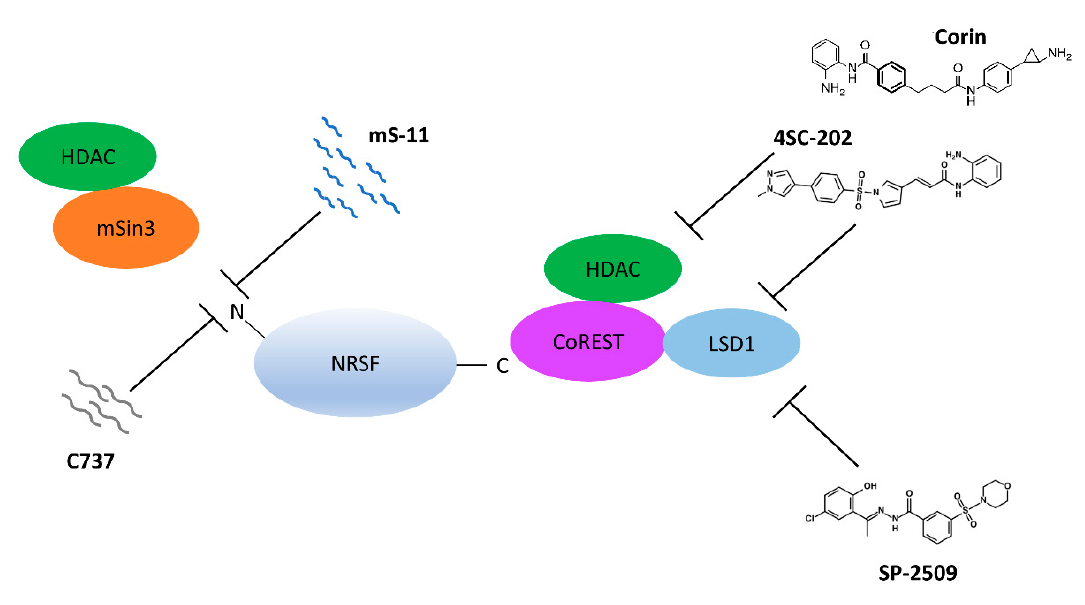
Figure 2. Inhibiting the Chromatin Modifying Effectors of NRSF. Inhibition of mSin3 recruitment by NRSF at the N-terminal end has been shown using molecules that mimic the helix structure of NRSF that recruits mSin3. At the C-terminal end of NRSF, small molecules against the major corepressor of NRSF, CoREST, can inhibit both deacetylase and demethylase